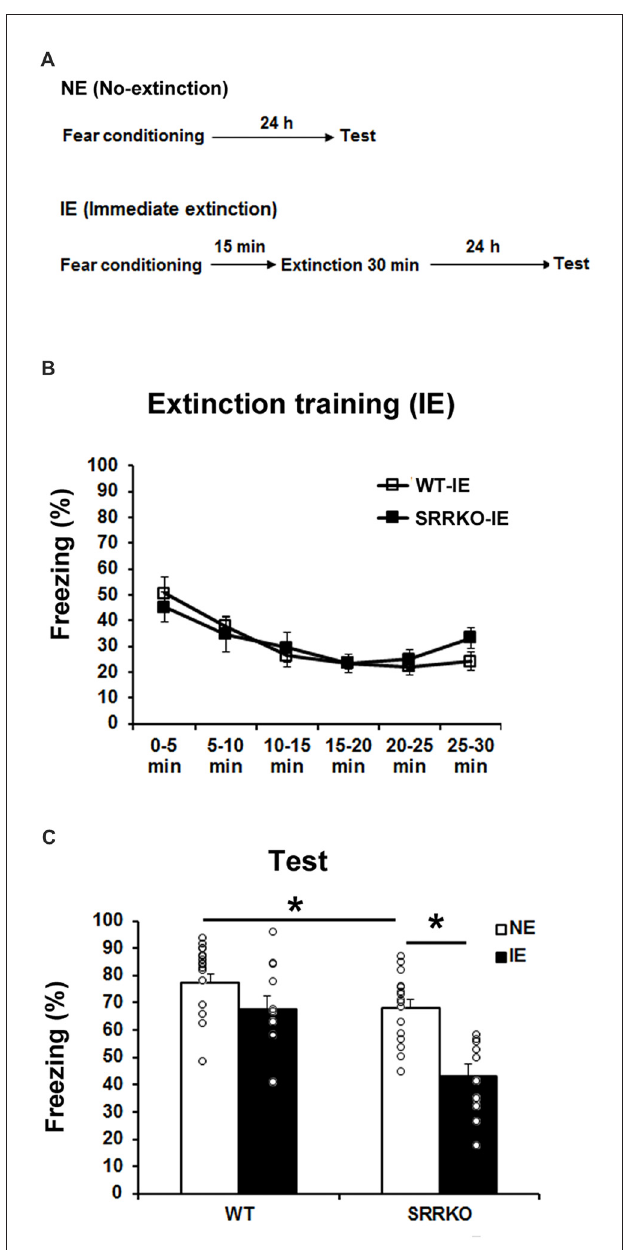
FIGURE 1 | Immediate extinction (IE) of contextual fear memory is facilitated in SRRKO mice. (A) Experimental schedule for contextual fear conditioning, IE and the recall test. (B) During the extinction training, there was no significant difference in within-session extinction between SRRKO-IE ( n = 10) and wild-type (WT)-IE ( n = 11) mice. (C) During the recall test, SRRKO-IE mice exhibited significantly lower levels of freezing than did no-extinction (NE) group of SRRKO mice (SRRKO-NE, n = 16; ∗ p < 0.05). There was no significant difference in freezing levels between WT-IE and WT-NE mice (WT-NE, n = 16). Data are presented as means ± SEM.